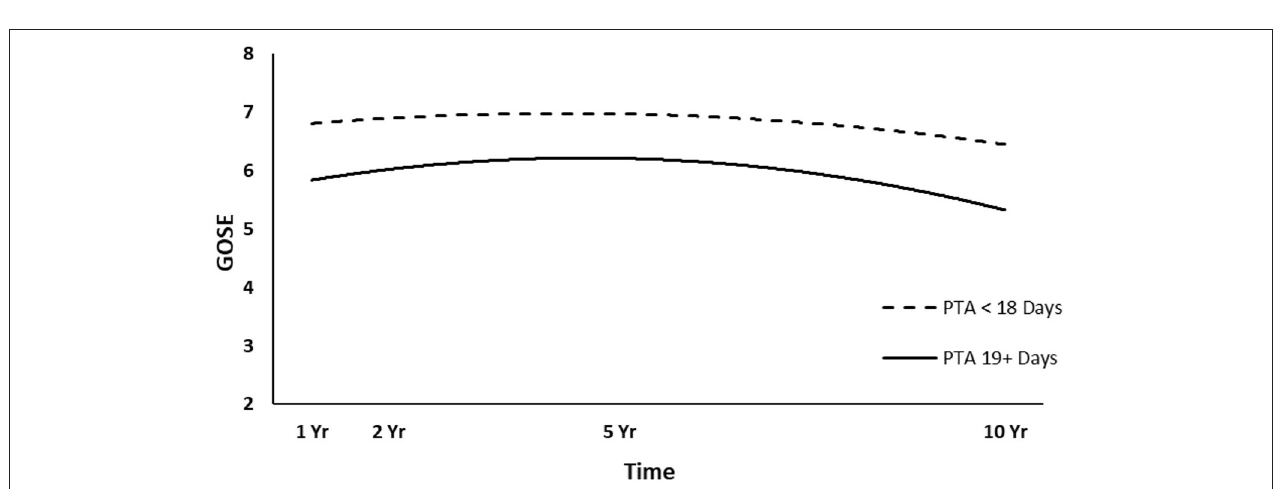
FIGURE 6 | Main effect and quadratic time interaction effect of post-traumatic amnesia (PTA) duration (dichotomized at median value) on GOSE